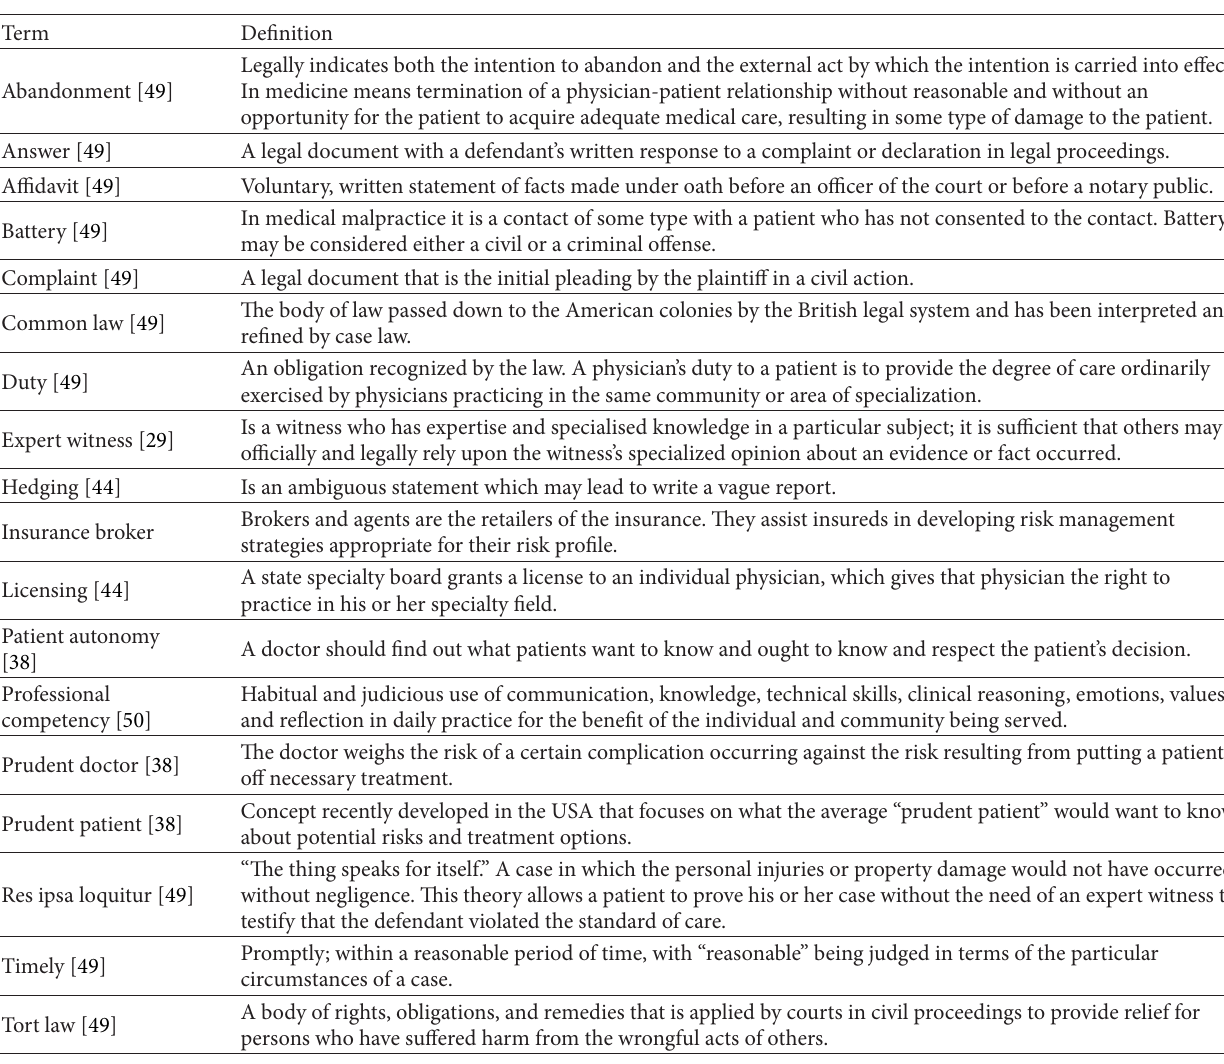
Table 1: Useful medical-legal terms and